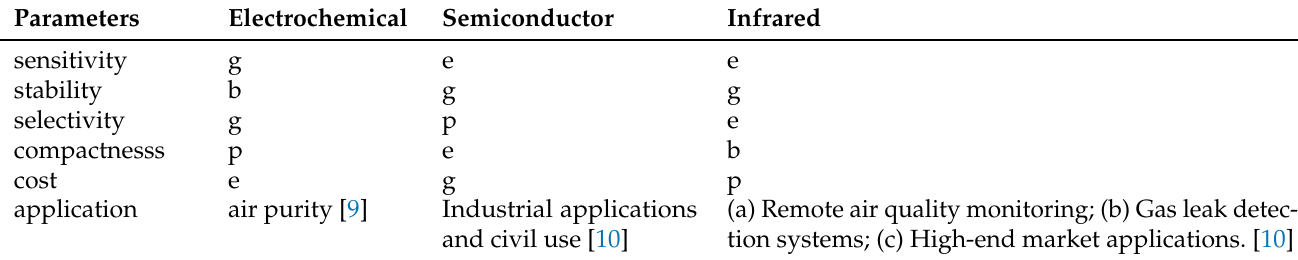
Table 1. Characteristics for various types of gas sensors based on